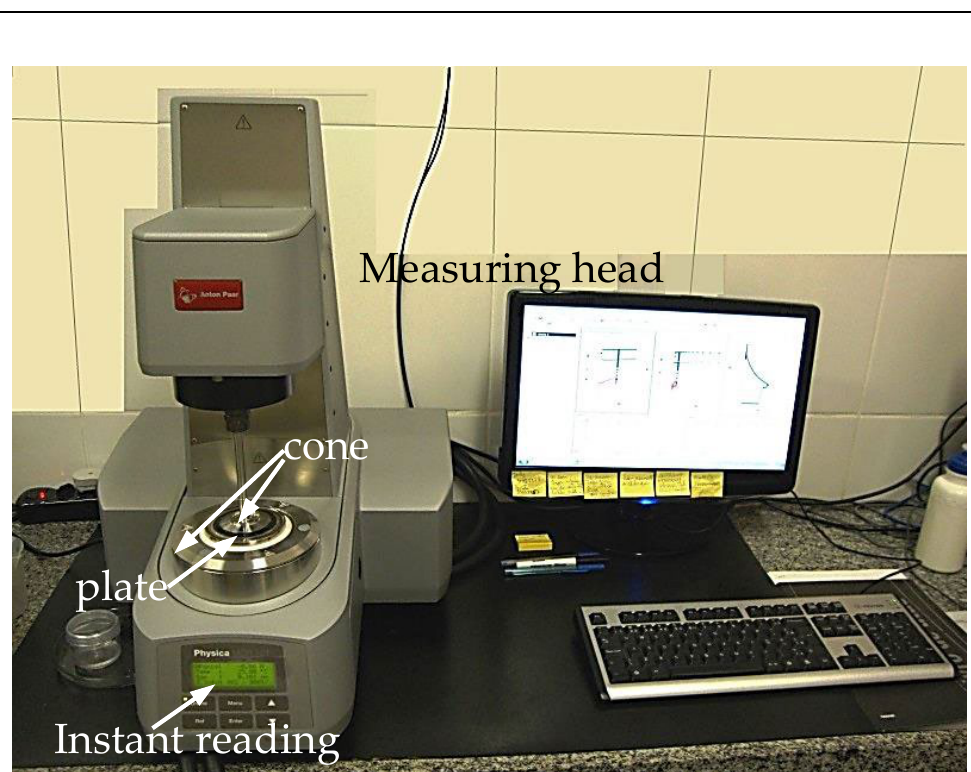
Figure 6. Rheometer MCR301.